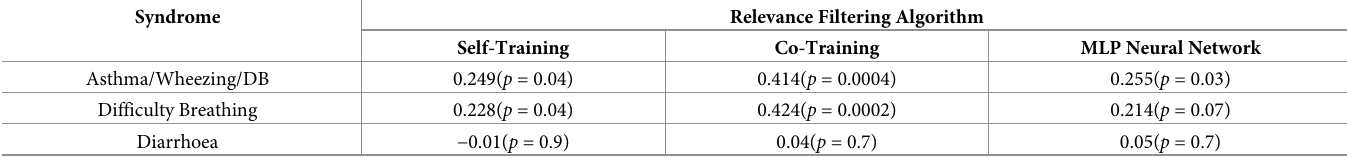
Table 15. Pearson correlations and P-Values for detected signals with syndromic surveillance